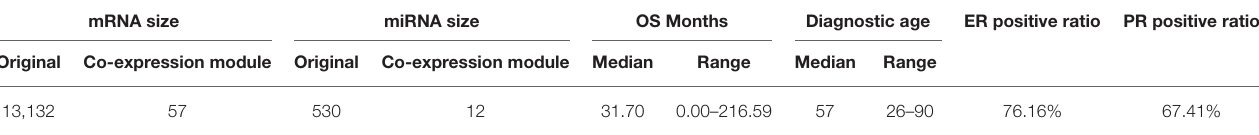
TABLE 1 | Demographical and clinical characteristics of 583 female breast invasive carcinoma (BRCA) patients. mRNA size miRNA size OS Months Diagnostic age ER positive ratio PR positive ratio Original Co-expression module Original Co-expression module Median Range Median